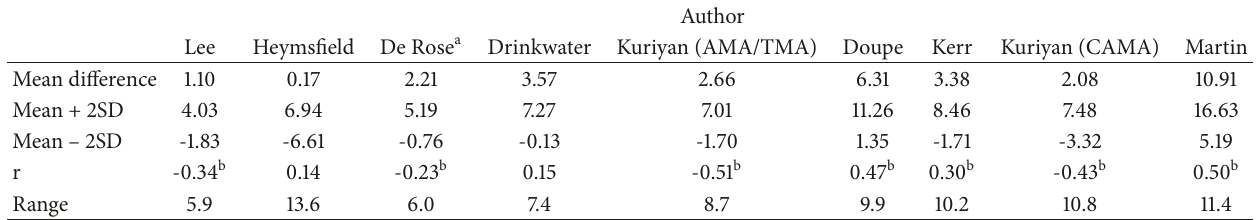
Table 4: Analysis of absolute (kg) skeletal muscle mass differences (equation – DXA) in professional male soccer players (n = 179).